Question: Based on the figure, does the quantity rise or fall?
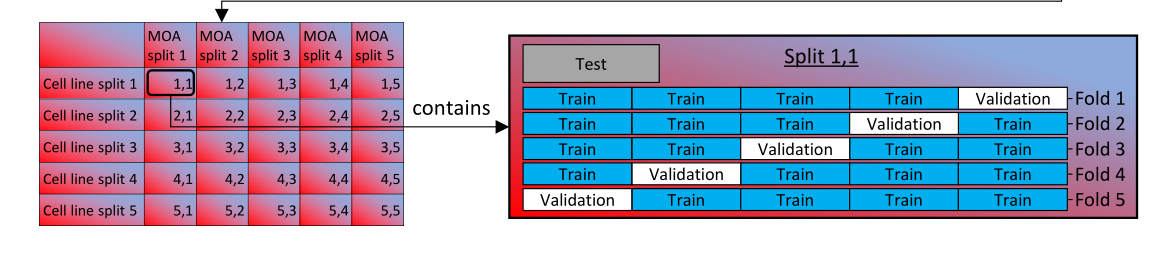
Answer: increasing